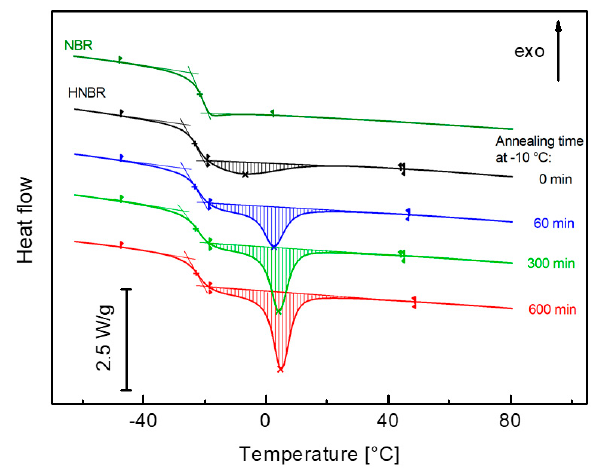
Figure 2. Differential Scanning Calorimetry (DSC) curves of HNBR and NBR (second run). The glass transition and melting peaks are evaluated. HNBR was annealed at − 10 °C.